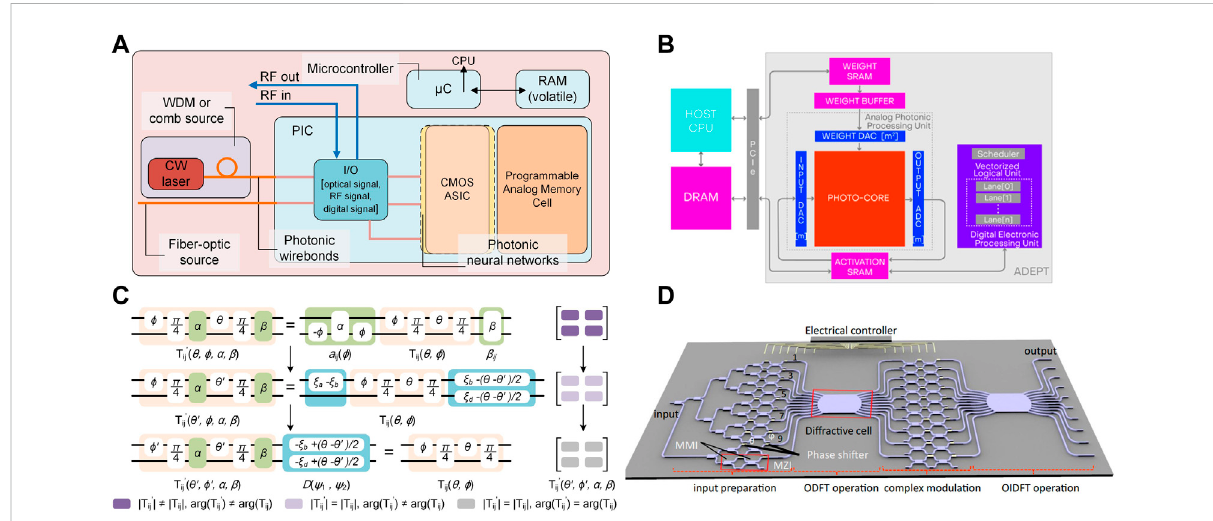
FIGURE 7 (A) The concept of the neuromorphic photonic processor with commercially available photonic packaging technology and some emerging ideas in the fi eld of integrated photonics [38]. (B) The schematic and work fl ow of an electro-photonic computing system [163]. (C) The principle of the hardware error correction in large-scale MZI networks [165]. (D) The schematic of the space-ef fi cient optical integrated diffractive neural networks [103]. (B) Reprinted from Ref. 163 with permission from arXiv preprint. (D) Reprinted from Ref. 103 with permission from Springer Nature: Nature